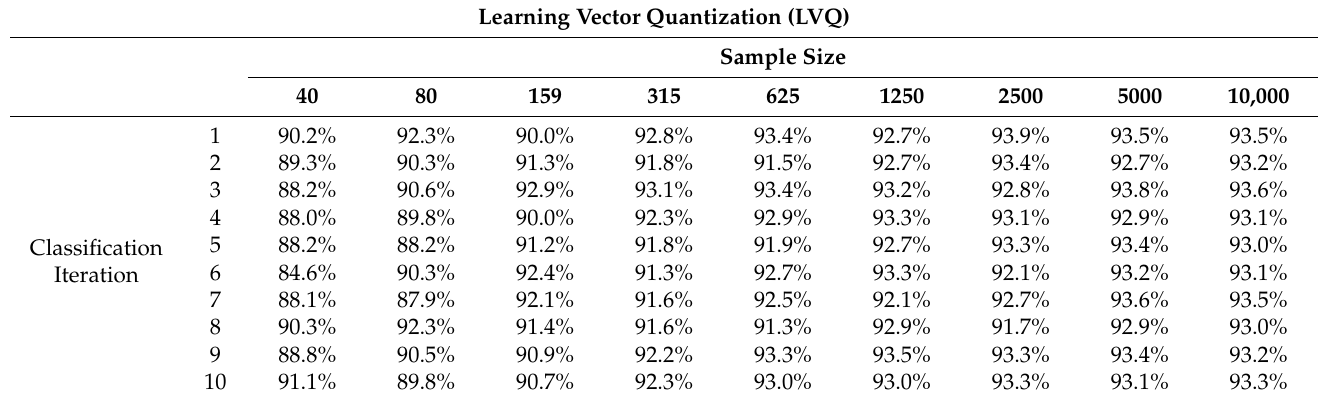
Table A5. Overall Accuracies of Learning Vector Quantization (LVQ) Classifications.